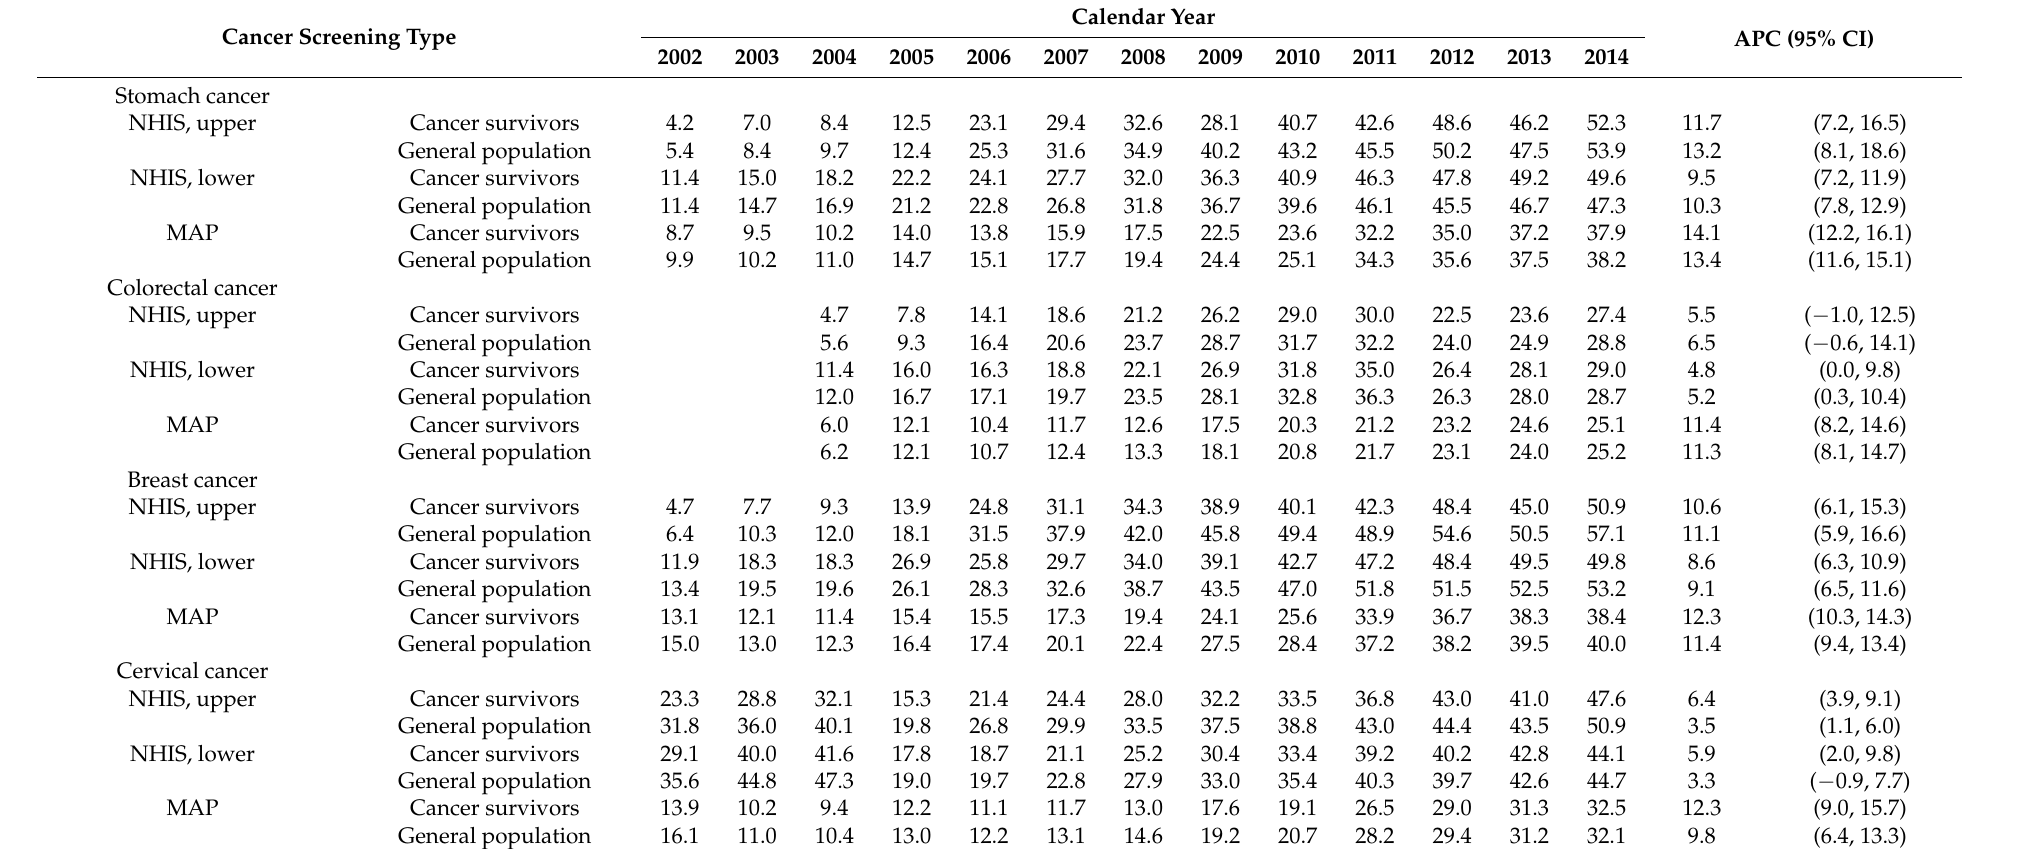
Table 3. Trends in participation rates (%) of the NCSP among cancer survivors and the general population by economic status. Cancer Screening